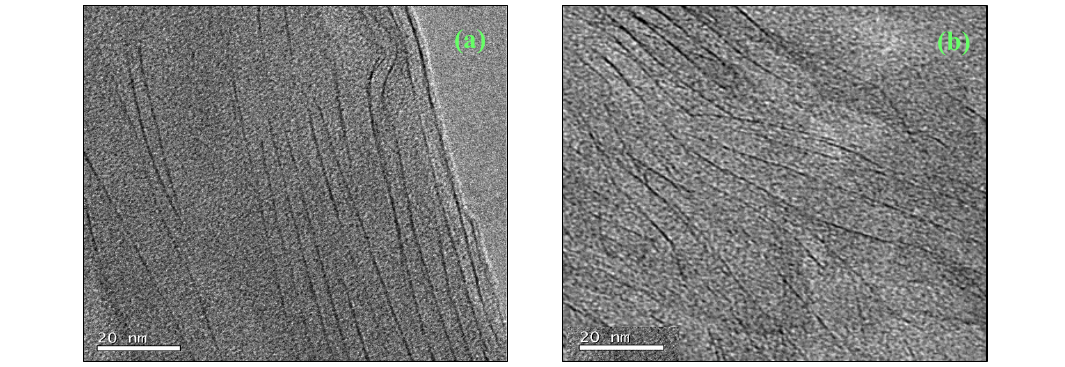
Figure 7. TEM micrographs for samples prepared by the standard procedure: ( a ) 5%, 150 °C and ( b ) 5%, 180